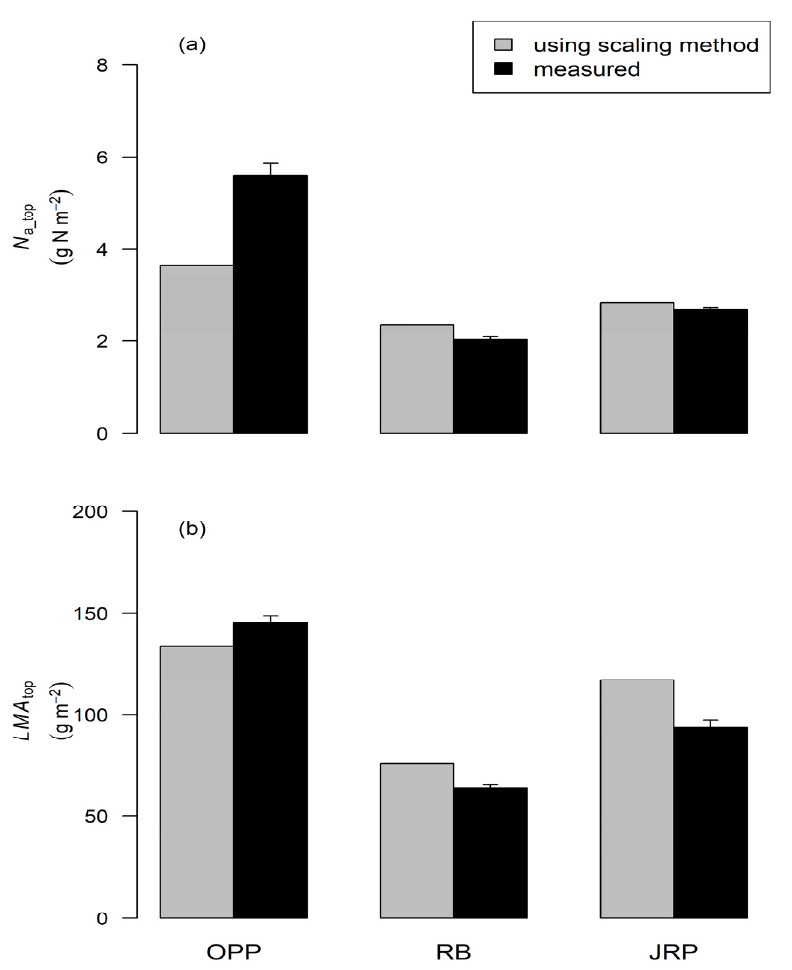
Figure 5. Comparison of leaf nitrogen content (( a ), N a_top ) and leaf mass per area (( b ), LMA _ top ) estimated at the top of the canopy via the scaling method with the measured values in OPP, RB and JRP.